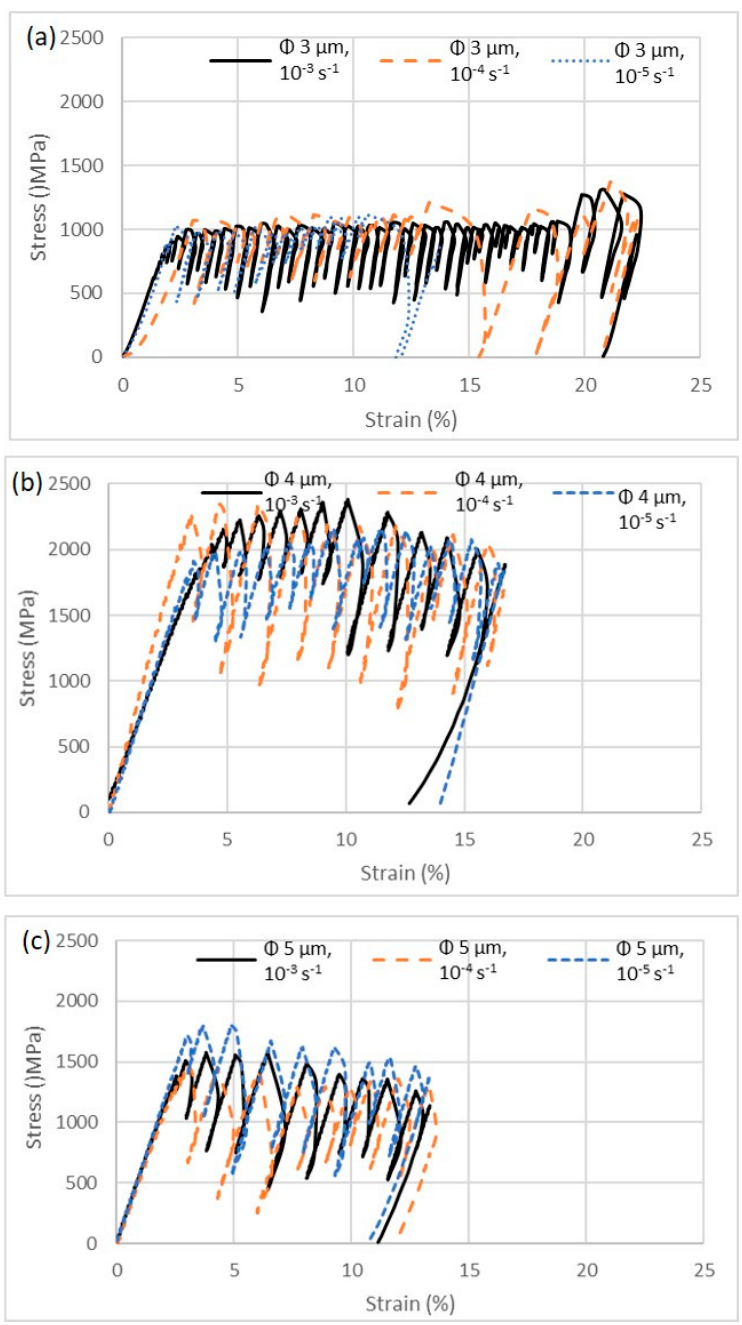
Figure 4. Effect of strain rate on stress–strain curves for a given micropillar diameter: ( a ) 3, ( b ) 4 and ( c ) 5 µm.